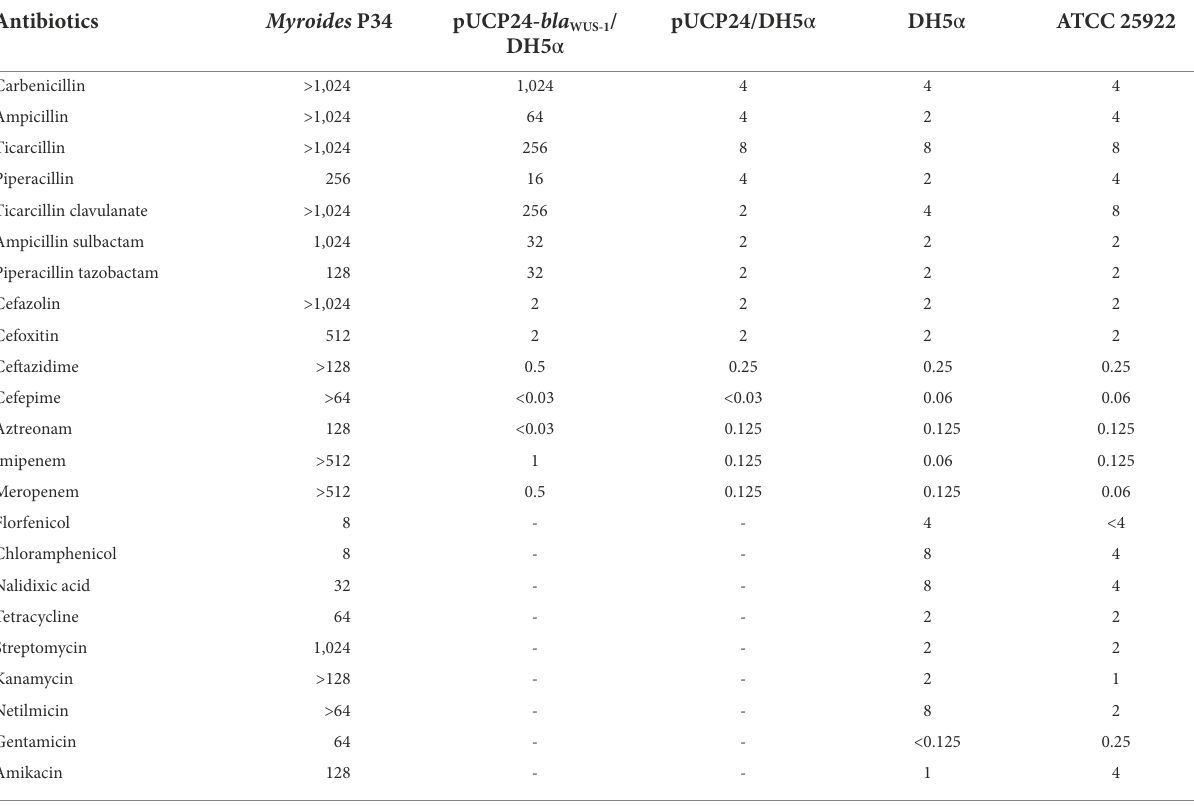
TABLE 3 MICs of 22 antimicrobials for P34, the recombinant carrying bla WUS-1 and the control strains (mg/L).